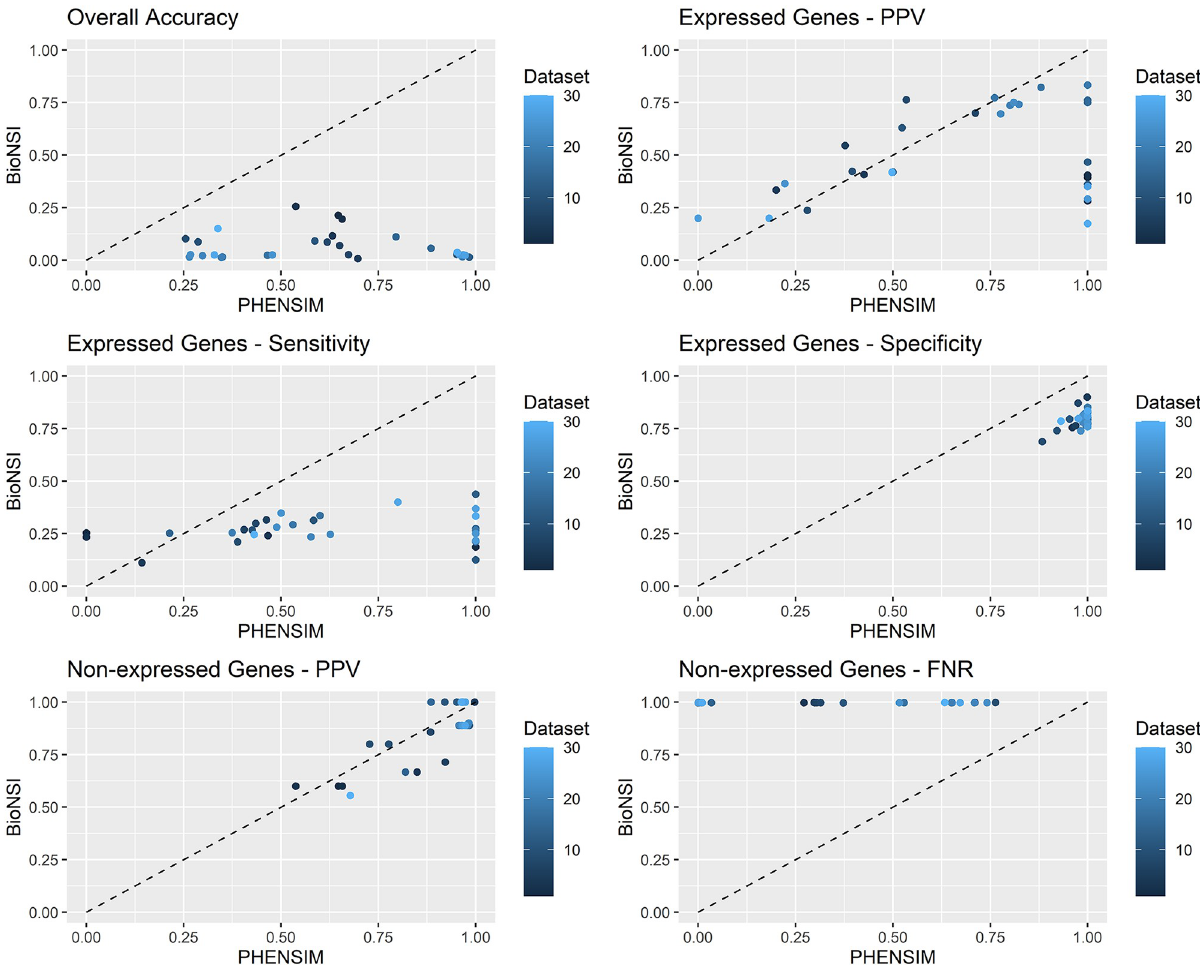
Fig 1. Comparison between PHENSIM and BioNSi for datasets where the altered gene was in the meta-pathway. Each graph reports one metric: Positive Predictive Value (PPV), Sensitivity and Specificity for genes showing altered expression, and PPV and False Negative Rate (FNR) for the non- altered ones. On the x-axis, we report PHENSIM performance, while on the y-axis, we present BioNSi. Each dot represents a dataset. The black line marks the points where the two algorithms have the same performance. On a dataset below the line, PHENSIM has better performance than BioNSi; above the line, it is the